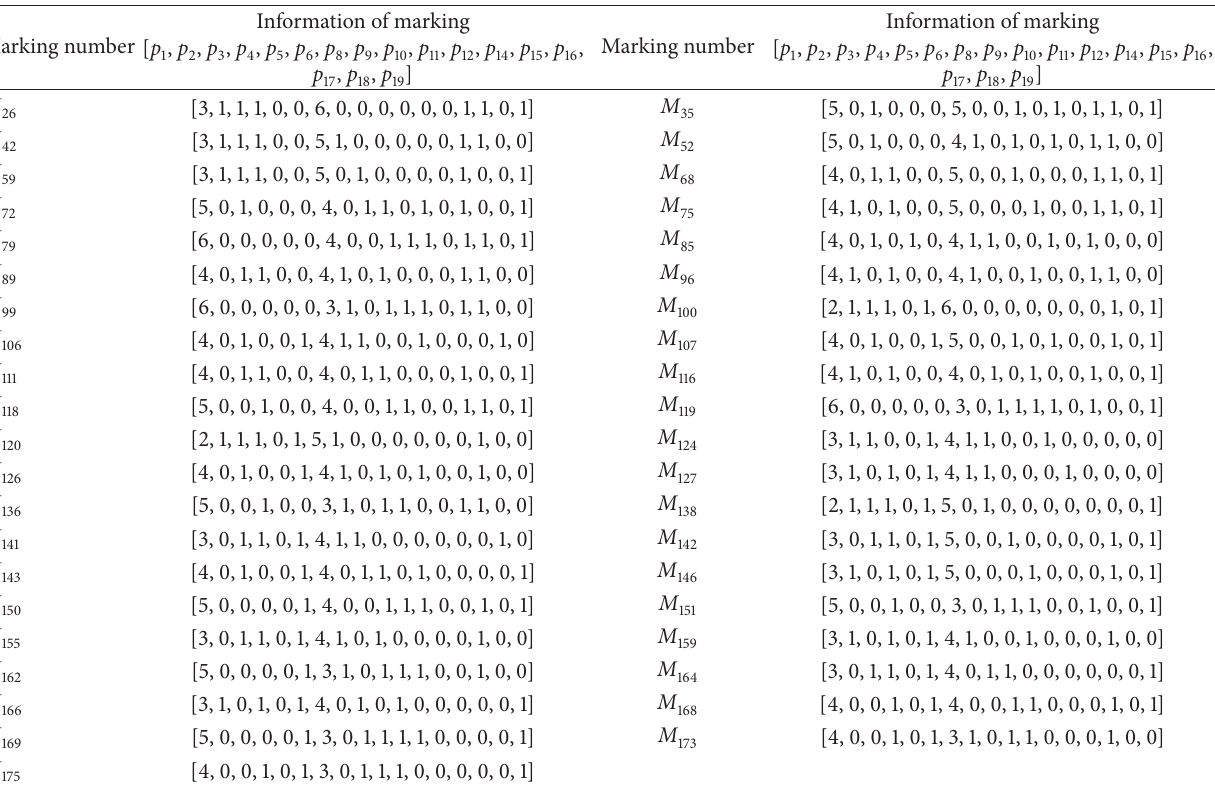
Table 3: The detailed information of quasi-dead